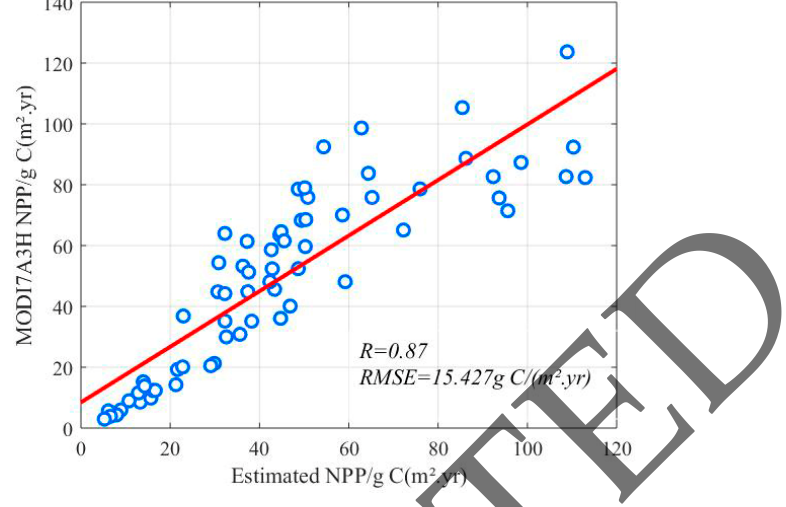
Figure 10. Comparison between the estimated NPP and MOD17A3H NPP.